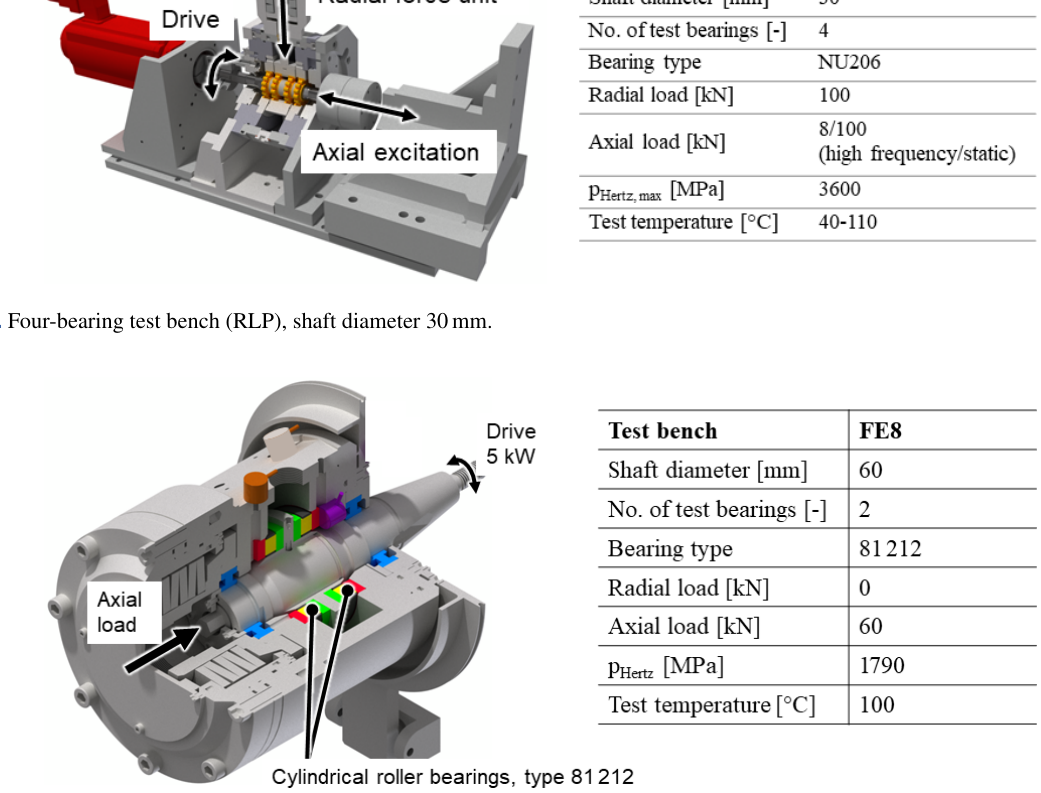
Figure 2. FE8-type test rig with test bearings of type 81212 according to the Deutsches Institut für Normung e. V